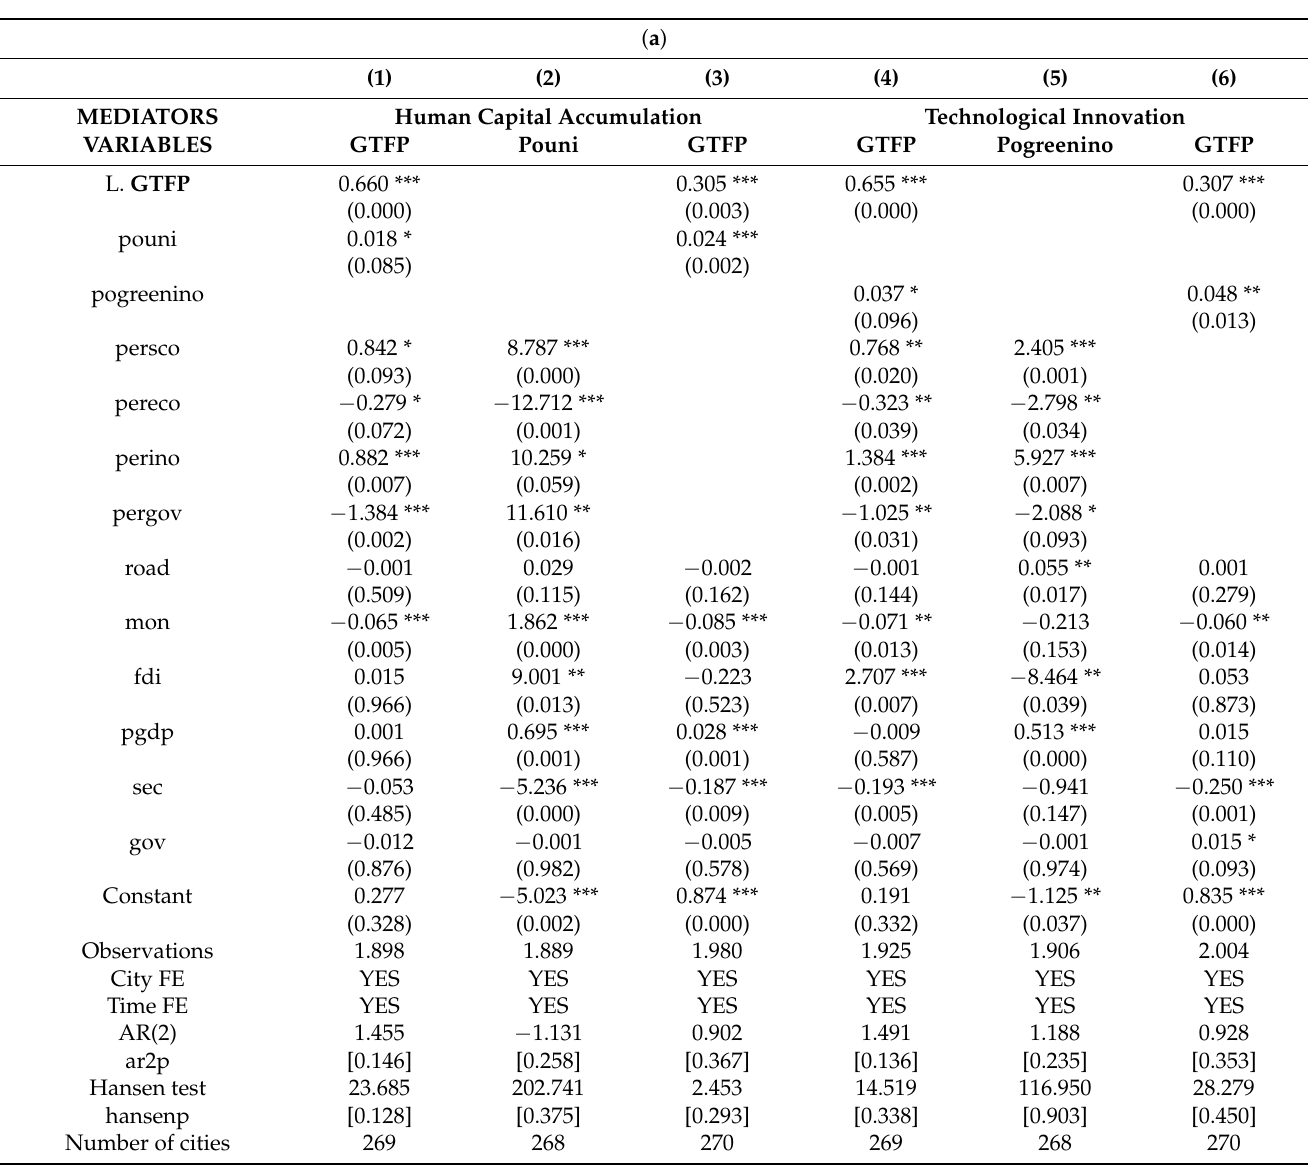
Table 8. ( a ) Estimation results of the dynamic panel mediation models. ( b ) Estimation results of the dynamic panel mediation